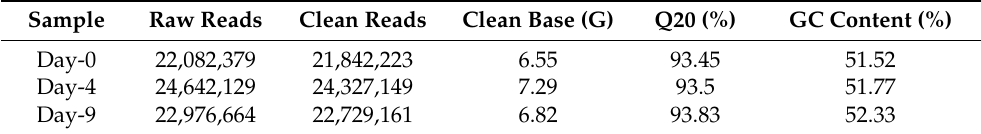
Table 1. Quality of Sequencing.